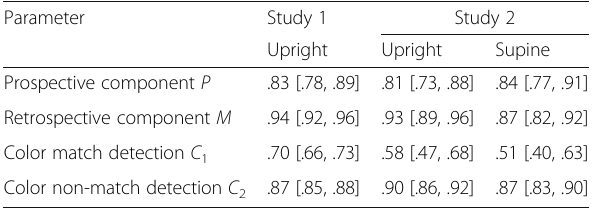
Table 1 Group parameter estimates for the MPT model and 95% Bayesian credibility intervals for Studies 1 and 2